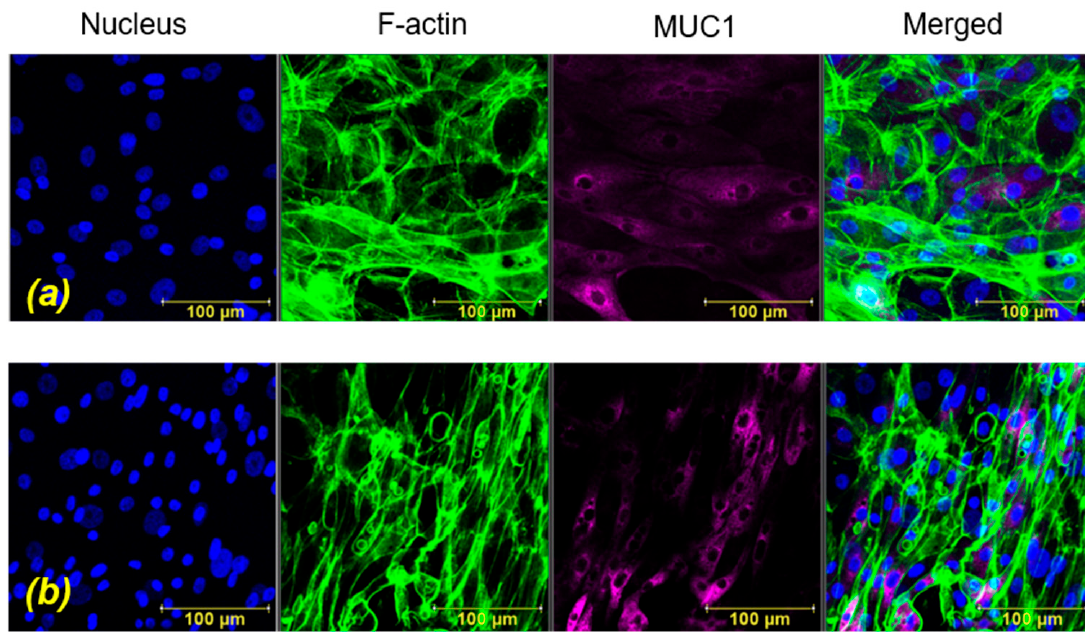
15 min. Immunofluorescence staining: nucleus (blue), F-actin (green), MUC1 (purple). min. Immuno fl uorescence staining: nucleus (blue), F-actin (green), MUC1 (purple).